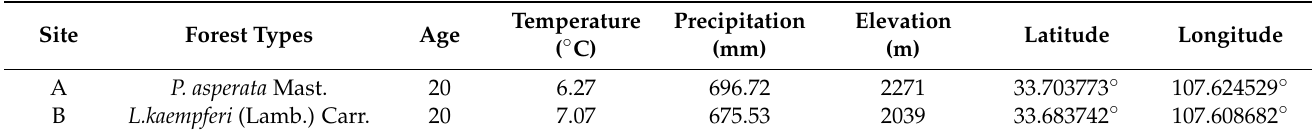
Figure 1. Geographical location diagram of the study area in Changqing National Reserve (NR). Table 1. Basic information of the research site.